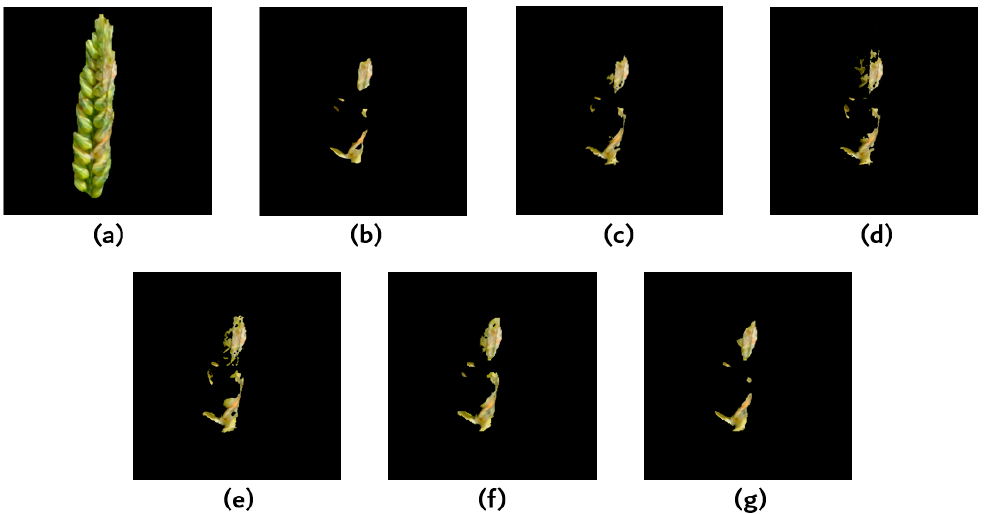
Figure 9. Examples of disease spot segmentation results. ( a ) Infected wheat ear image, ( b ) artificially labeled disease spot, ( c ) IABC-K-PCNN algorithm to segment disease spot, ( d ) Otsu algorithm to segment disease spot, ( e ) genetic algorithmto segment disease spot, ( f ) super green featurealgorithm to segment disease spot, ( g ) ABC-PCNN algorithm to segment disease spot.